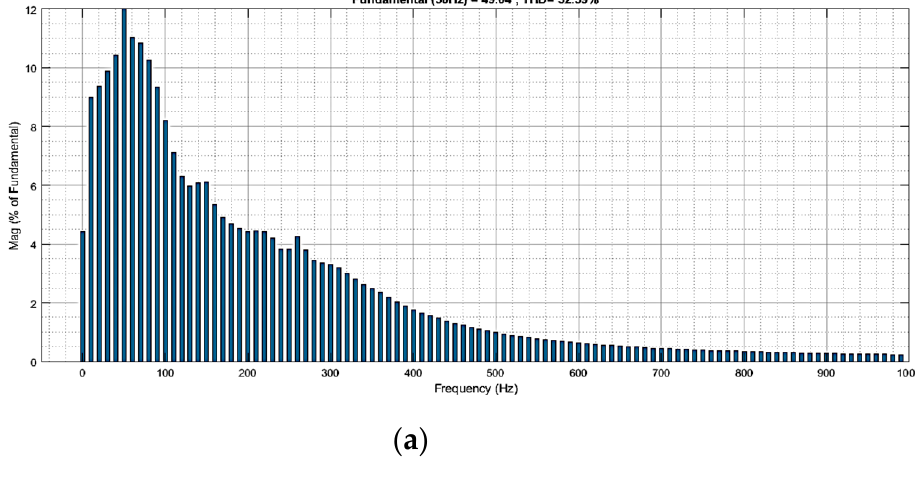
Figure 11. The THD values of output voltage and current for the 3-phase inverter interfaced with HS-SZSC, ( a ) voltage waveform, and ( b ) current waveform.